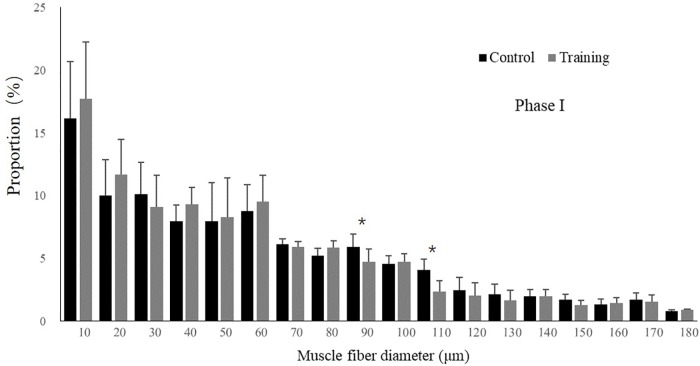
Distribution of fiber size in the control and training groups (mean ± SD) in Phase I (n = 12). ∗Significant differences between the experimental groups (P < 0.05).